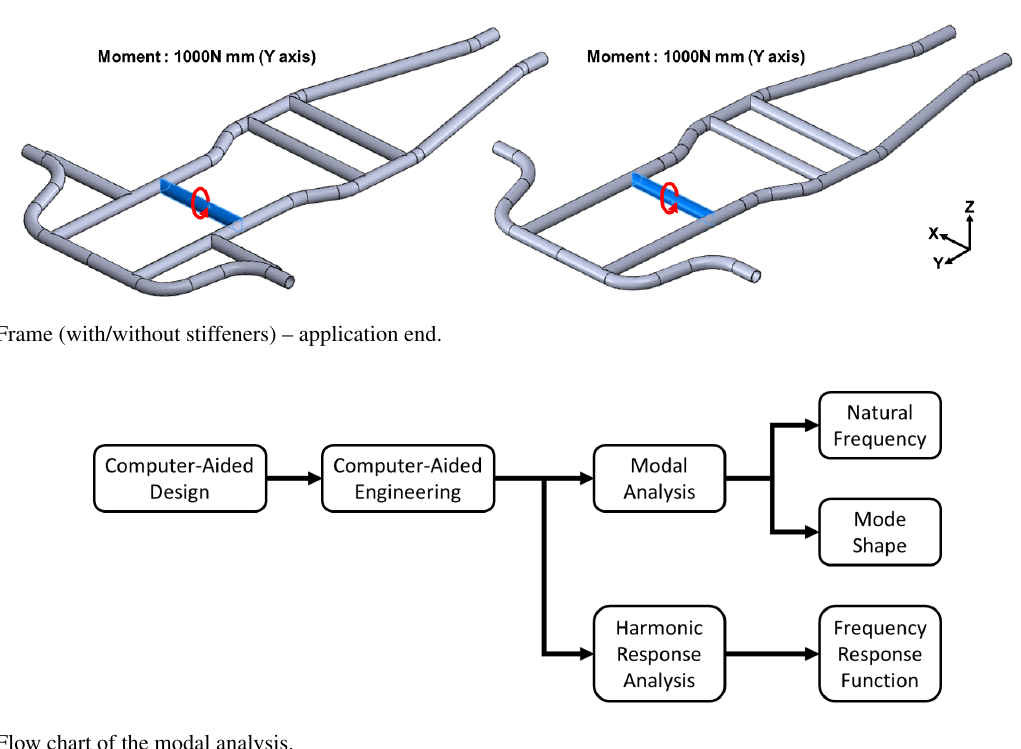
Figure 22. Flow chart of the modal